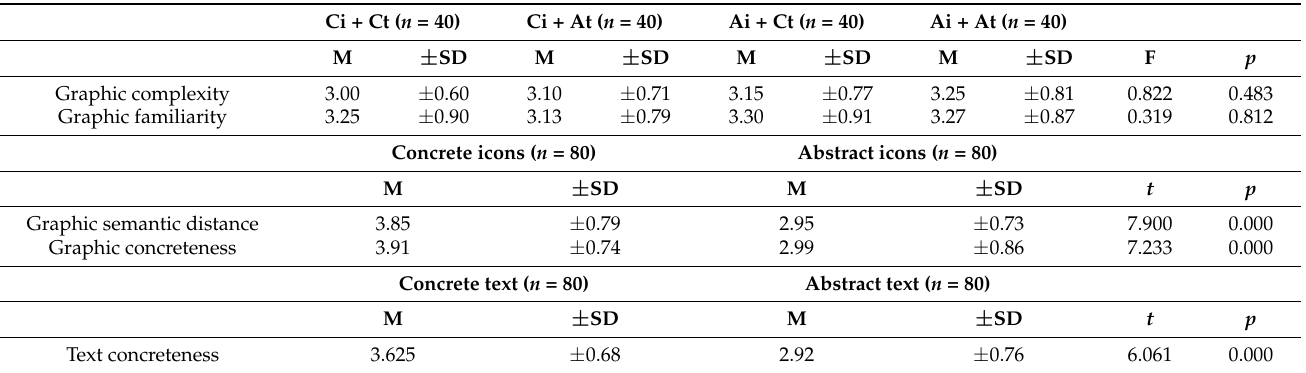
Table 1. Mean scores and standard deviation for icon and text complexity, familiarity, semantic distance and concreteness.